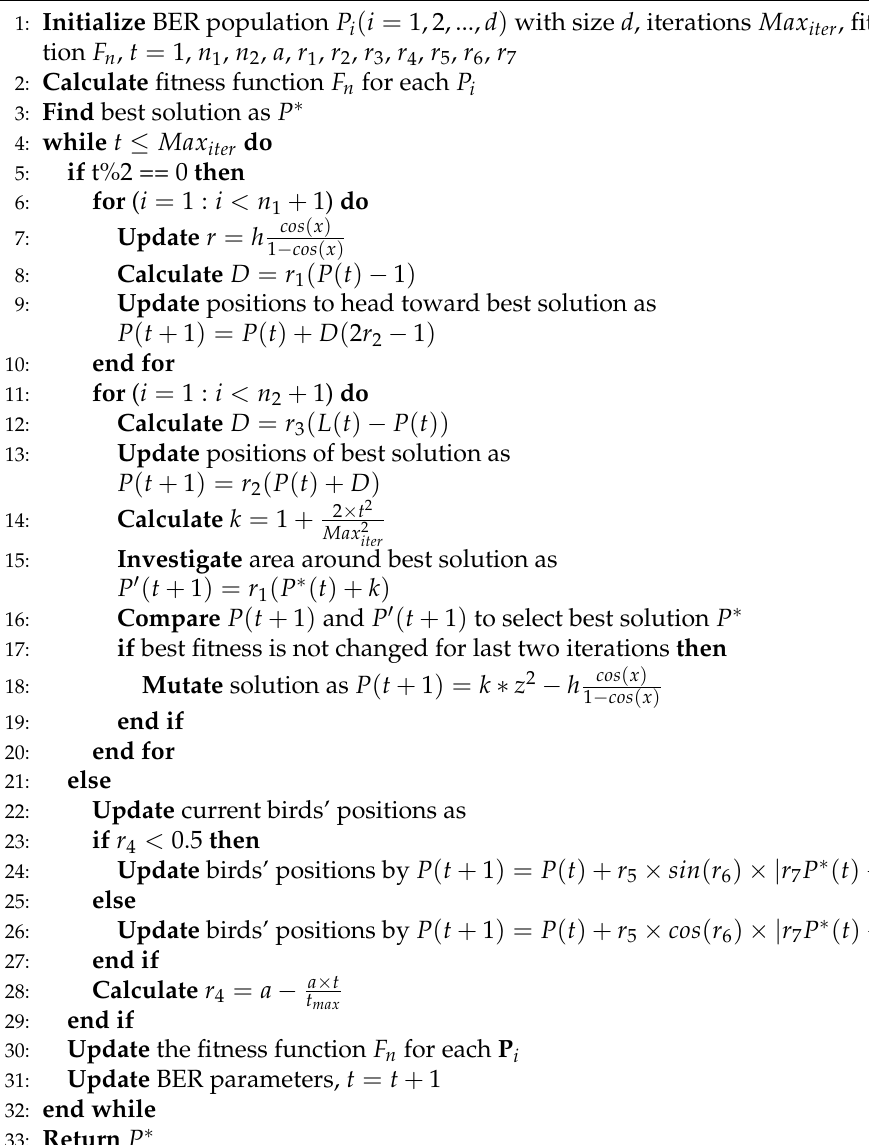
Algorithm 3 The proposed SCBER optimization